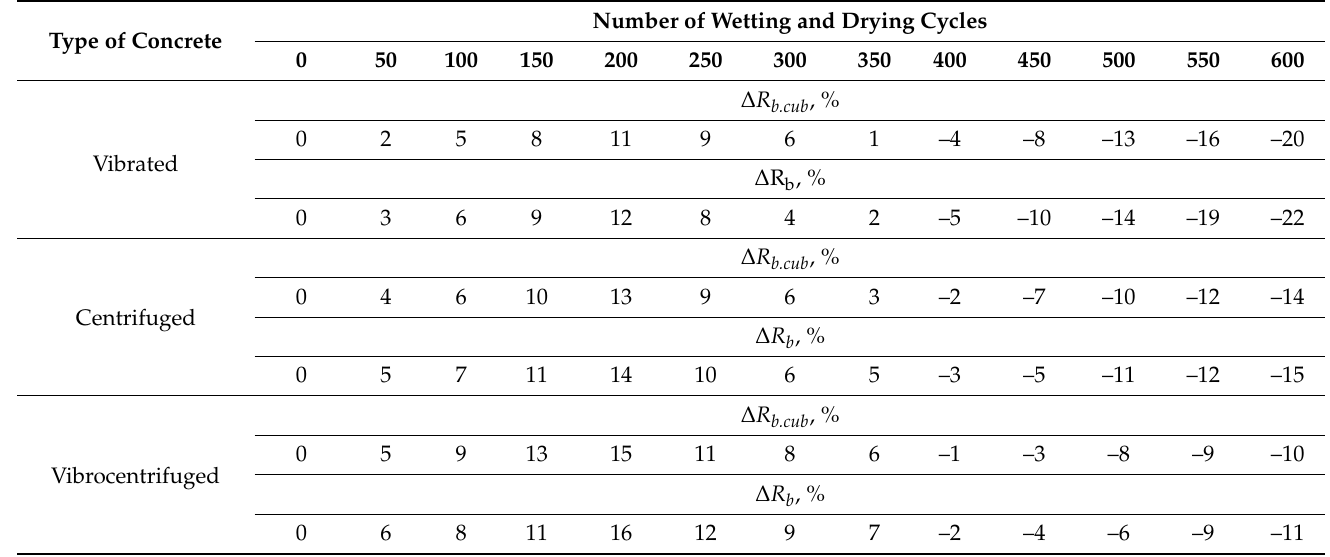
Table 5. Change in the strength characteristics of vibrated, centrifuged, and vibrocentrifuged con- cretes after cyclic wetting and drying at pH 7.